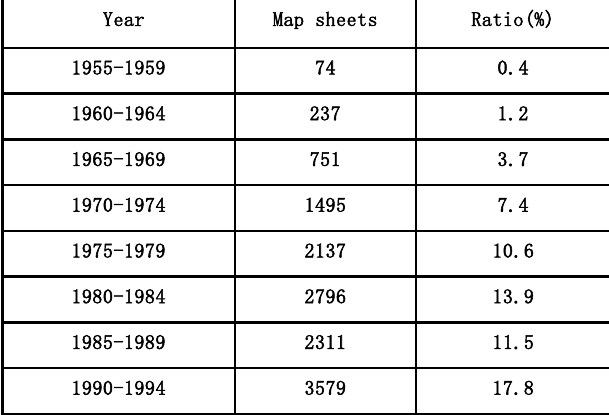
Table.4 The up-to-dateness of 1:50000 DLG before updating Year